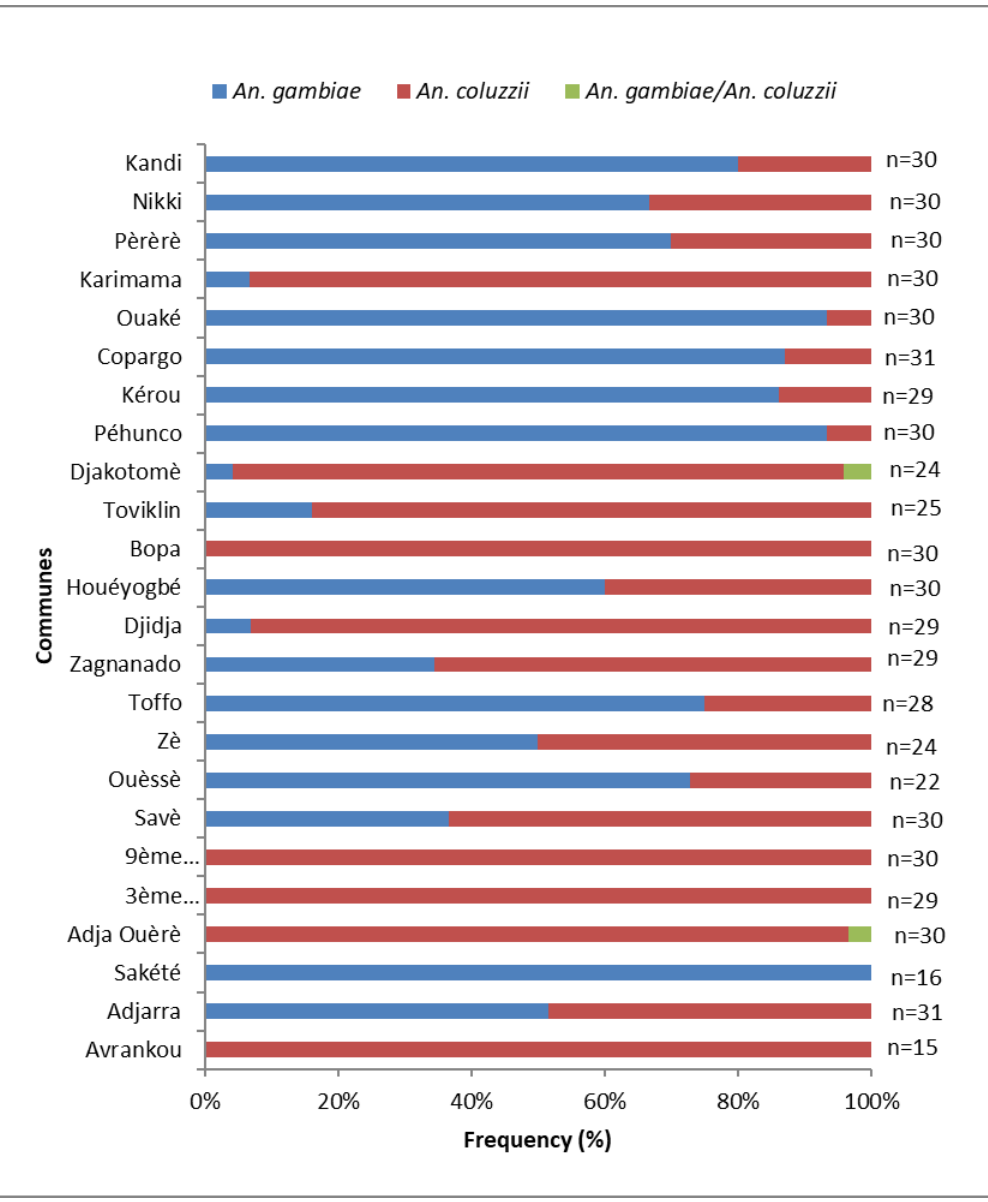
Figure 3. Distribution of related species of the Anopheles gambiae complex in the study communes.